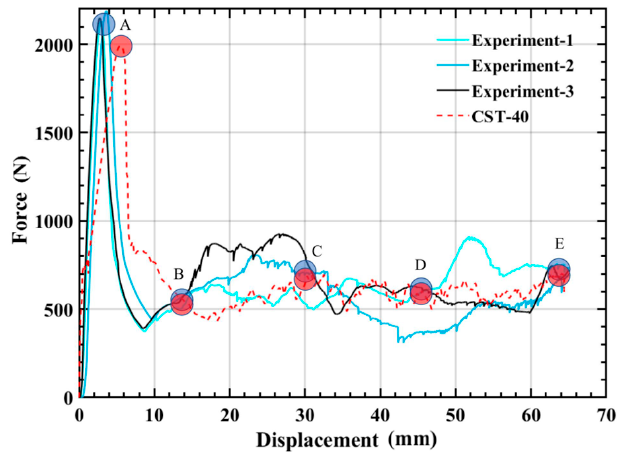
Table 2. At 40 °C, the experimental and simulated comparison results of various energy absorption indicators of CST. (EA is the average of the three experiments.).